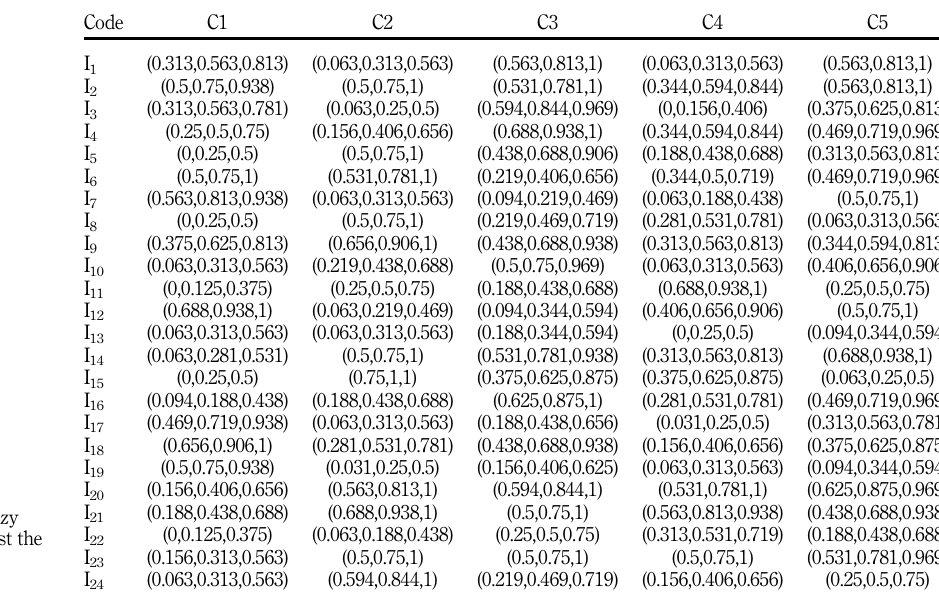
Table 3. Aggregate fuzzy weights against the criteria and